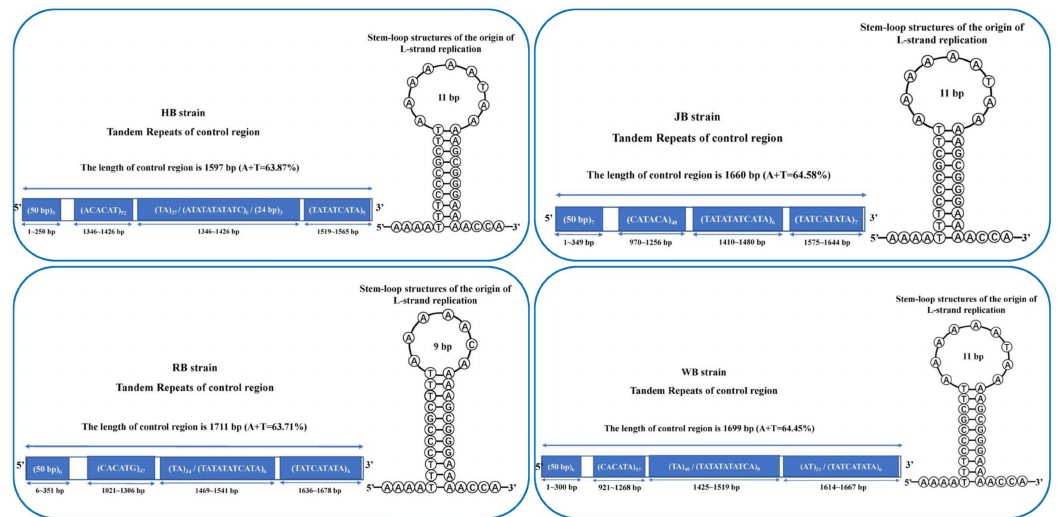
Figure 7. Comparison of length, nucleotide composition in control regions (CRs), and stem-loop structures of origin of L-strand replication for four P. sinensis strains